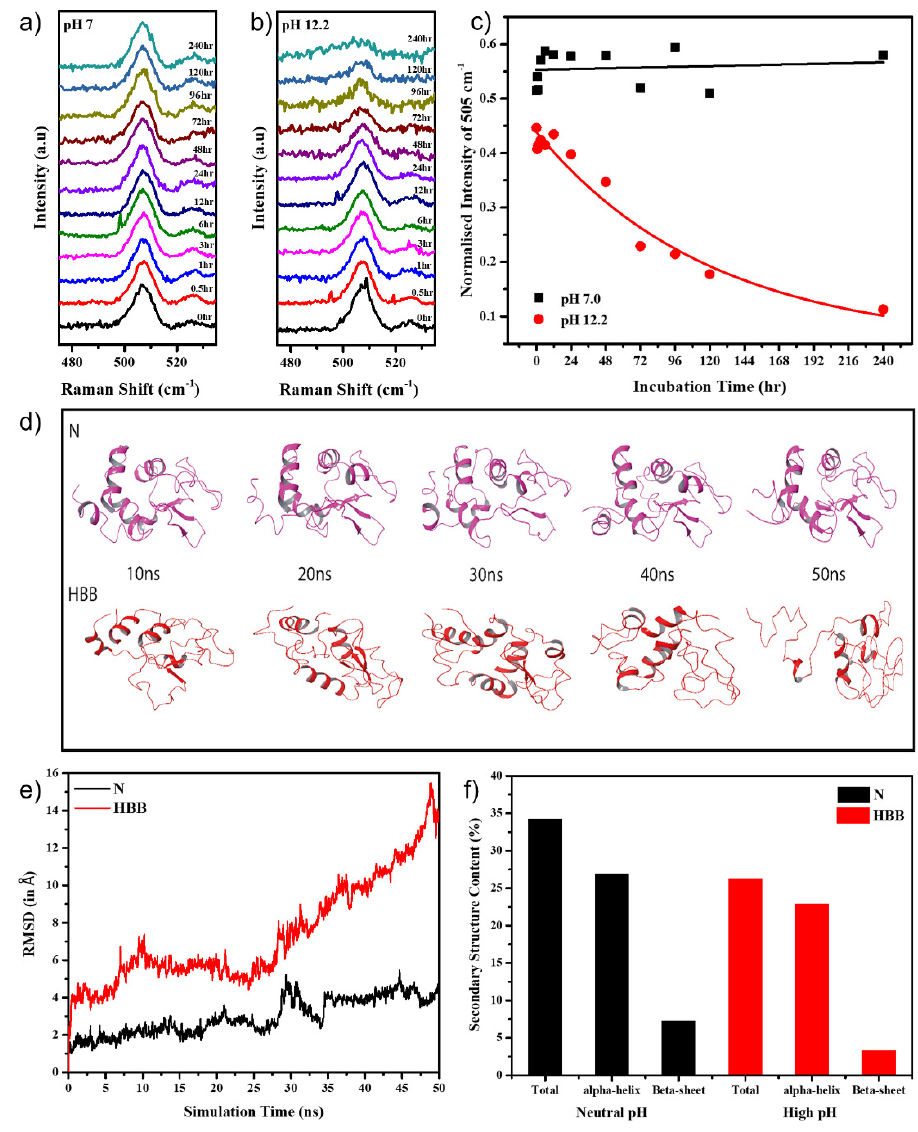
Figure 2. Intensity of 505 cm − 1 Raman peak in ( a ) pH 7.0 and ( b ) pH 12.2; ( c ) intensity vs. time plot for 505 cm − 1 Raman peak; ( d ) various frames of the HEWL monomer at different simulation time points, in N and HBB conditions; ( e ) RMSD of the HEWL monomer in neutral pH and high pH with disulphide bonds broken in a 50 ns simulation; ( f ) secondary structure content in N and HBB after the simulation.